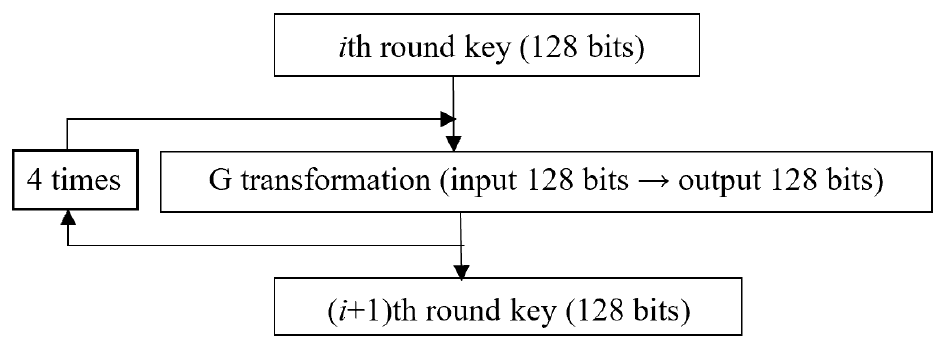
Figure 2. Scheme of the round key algorithm.